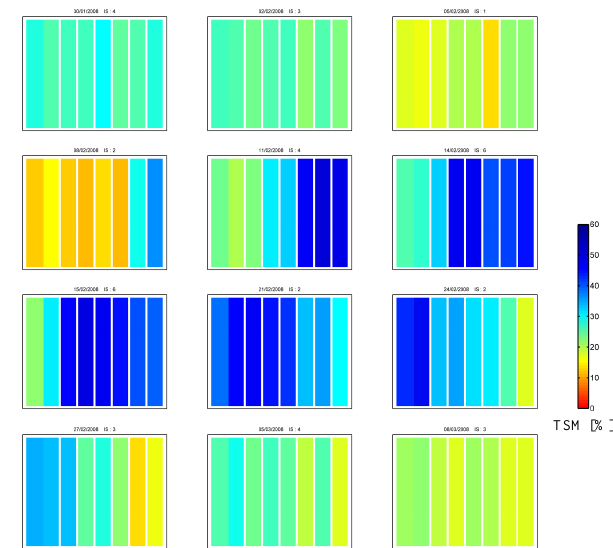
Fig. 11. Topsoil moisture (TSM) mapped over the different geo- Figure 11.  Topsoil moisture (TSM) mapped over the different geographical units (about 5 ha) of the graphical units (about 5ha) of the field 5 (see Table 3 and Fig. 1). field 5 (see Table 3 and Fig.1). The 12 first dates, corresponding to those shown on Fig. 10, are The 12 first dates, corresponding to those shown on Fig. 10, are presented together with the incidence angle of the based Envisat acquisition. presented together with the incidence angle of the based Envisat